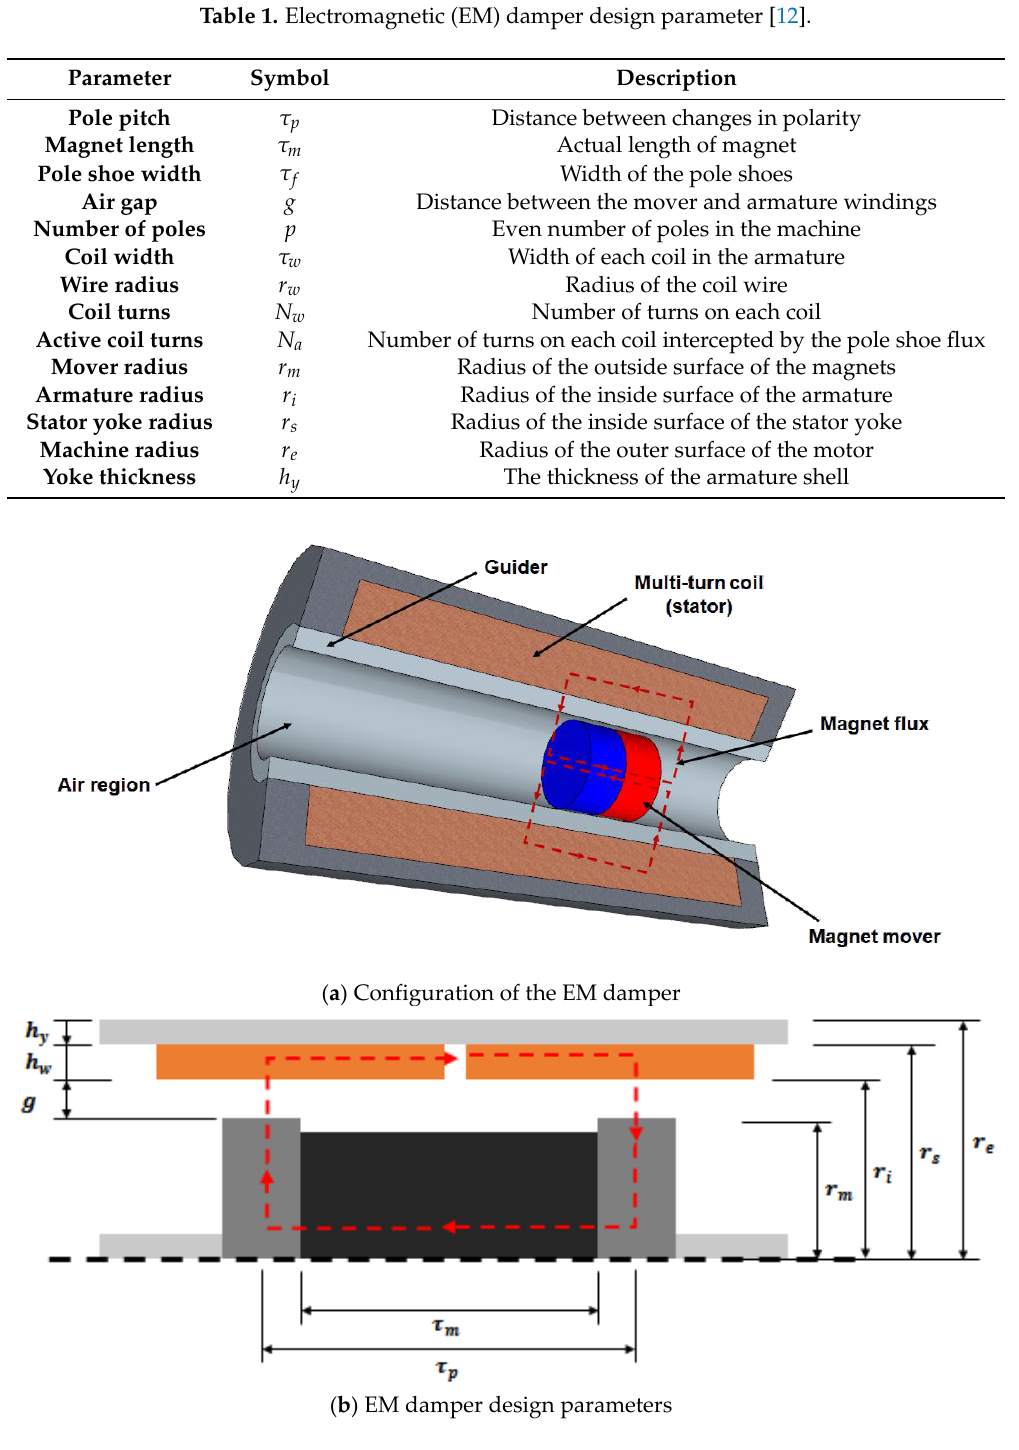
Figure 1. Electromagnetic (EM) damper configuration and design parameters [12]. Table 1. Electromagnetic (EM) damper design parameter [12].